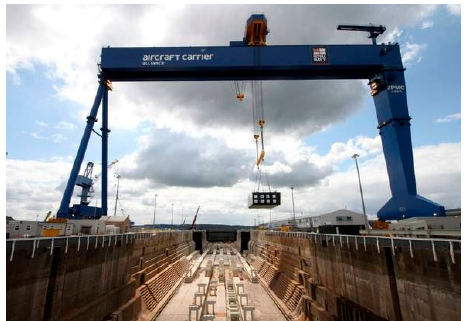
Figure 1. Hoisting positioning.